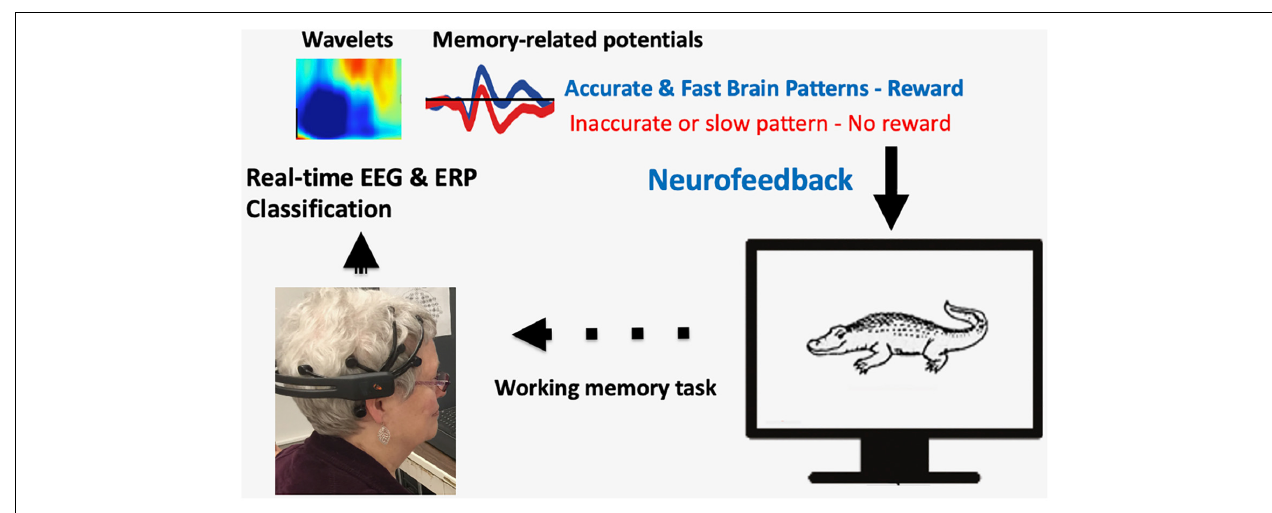
FIGURE 1 | A sample illustration of closed-loop Neurofeedback training for memory improvement. A participant wearing a wireless EEG headset performs a visual memory task. Recorded EEG signals are analyzed in real-time, e.g., EEG wavelet analysis (frequency, power, and time) or ERP memory-related potentials. Neurofeedback is given by rewarding brain patterns that are associated with accurate and fast memory